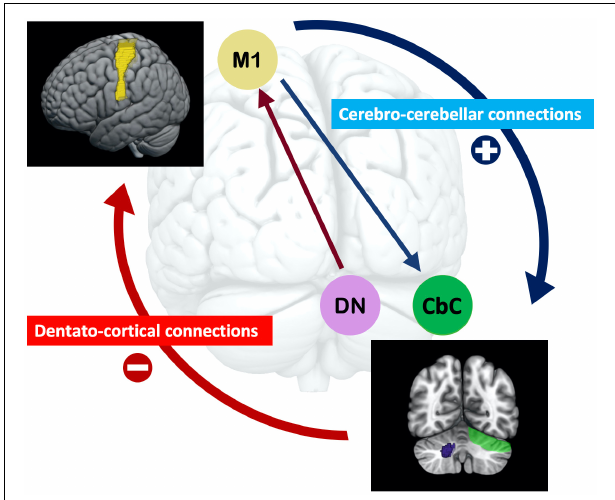
FIGURE 4 | The opposite effect of the baseline afferent and efferent pathways of functional connectivity of the cerebellum for visuomotor learning. The higher baseline functional connectivity of the cerebro-cerebellar pathway, the better accuracy learning performance; and the lower baseline functional connectivity of the cerebellar-cerebral pathway, the better stability learning performance in the visuomotor task. Functional connectivity in the efferent dentato-cerebral pathway is related to the dentato-thalamo-cortical pathway, in which the dentate nucleus reduces inhibition signals from Purkinje cells. The disinhibition of these inhibitory projections is essential for visuomotor learning. (M1 = motor cortex; DN = dentate nucleus; CbC = cerebellar